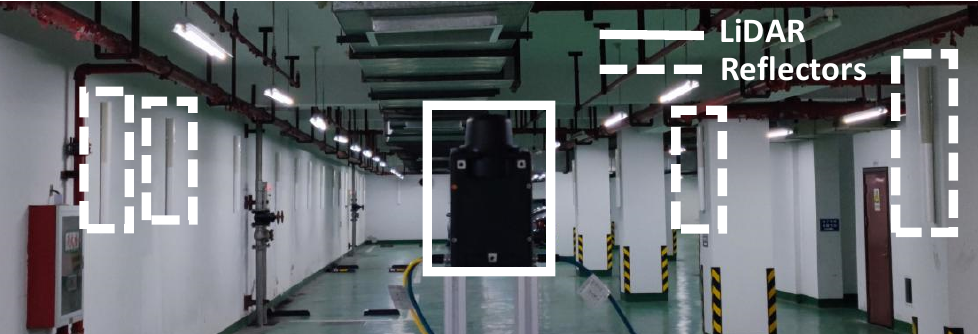
Figure 1. Hardware required for the reflector positioning system. The black device indicated by the solid line is a 2D LiDAR. The white pipes indicated by dotted lines are reflectors.